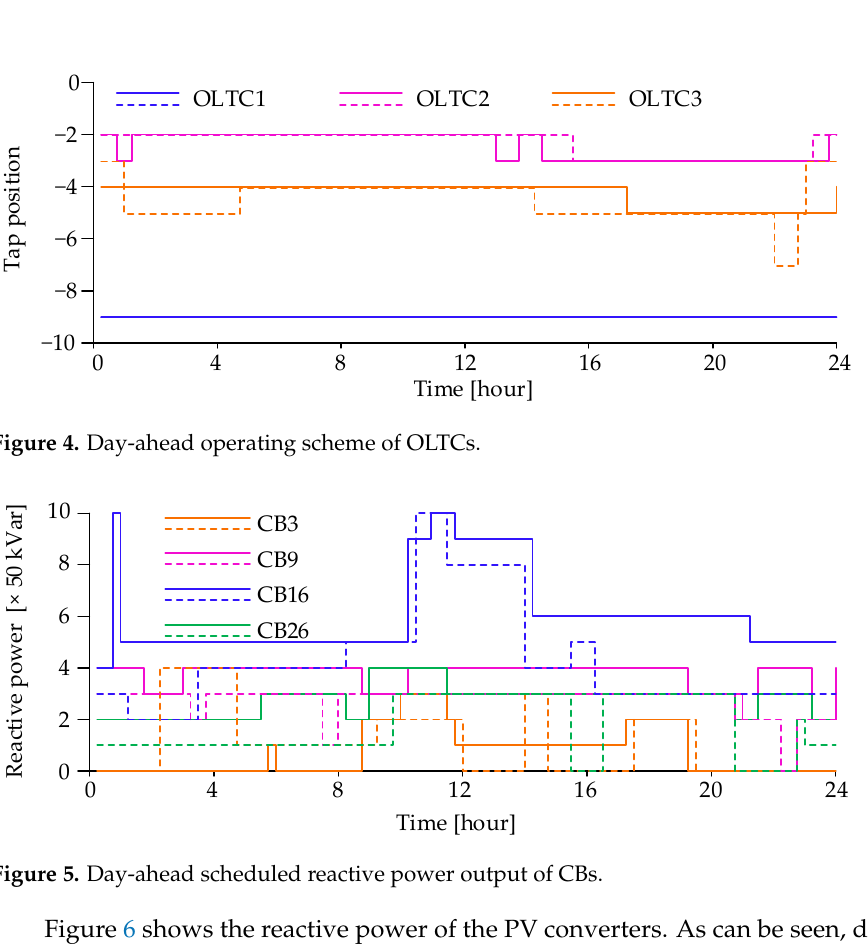
12 of 21 Figure 3. Daily reactive load profile. The lower and upper bound of the voltage amplitude are 0.95 p.u. and 1.05 p.u., re- spectively. Without loss of generality, we assume that the voltage at bus 0 is fixed to be unity, i.e., 0 v